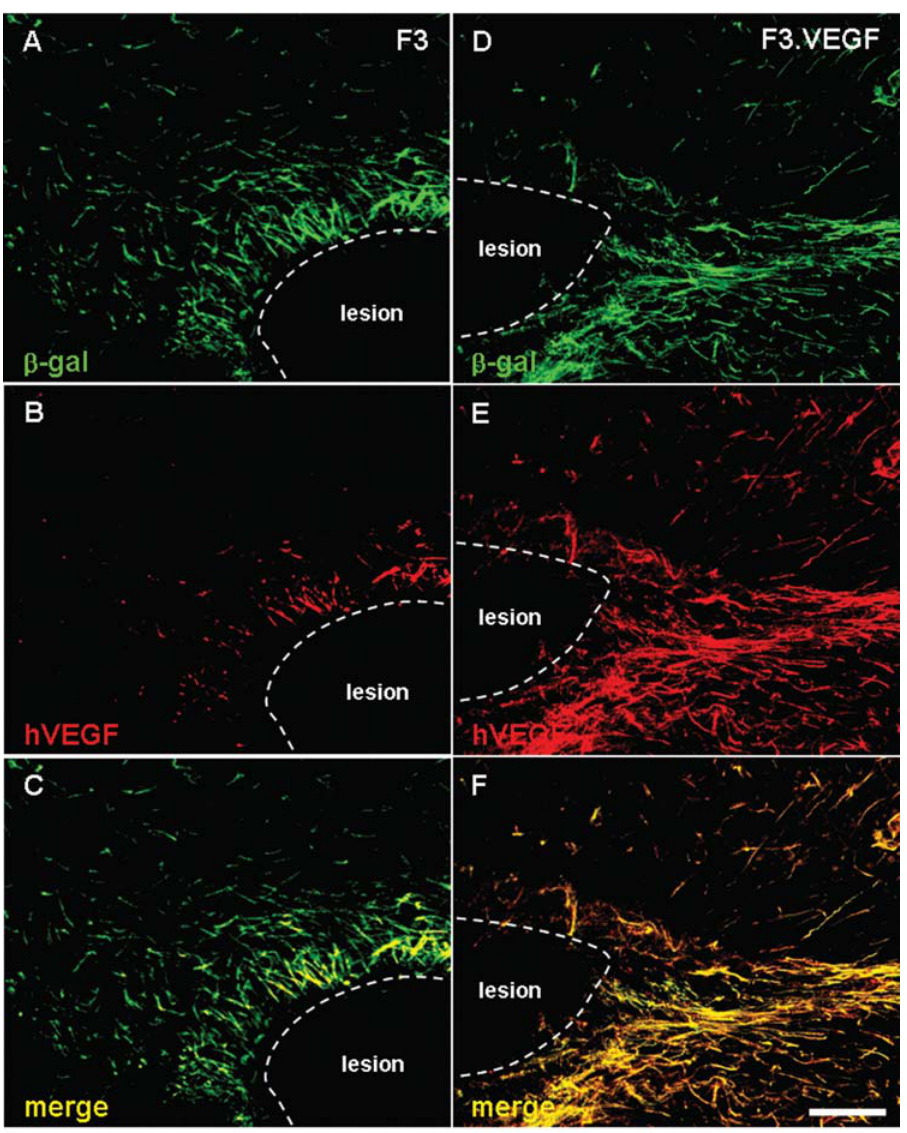
Figure 3. Double immunofluorescence microscopy demonstrating b -gal + /VEGF + F3 cells (A–C) and b -gal + /VEGF + F3.VEGF cells (D–F) in the hemorrhage core borders 8 weeks post-transplantation. A markedly higher number of b -gal + /VEGF + cells were found in the brain region grafted with F3.VEGF cells. Bar indicates 50 m m.